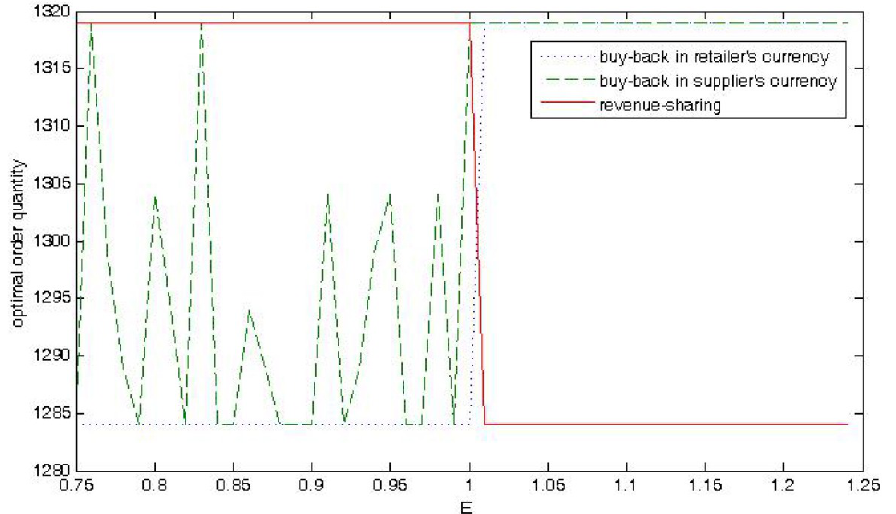
Figure 4. The revenue-sharing contract versus buy-back